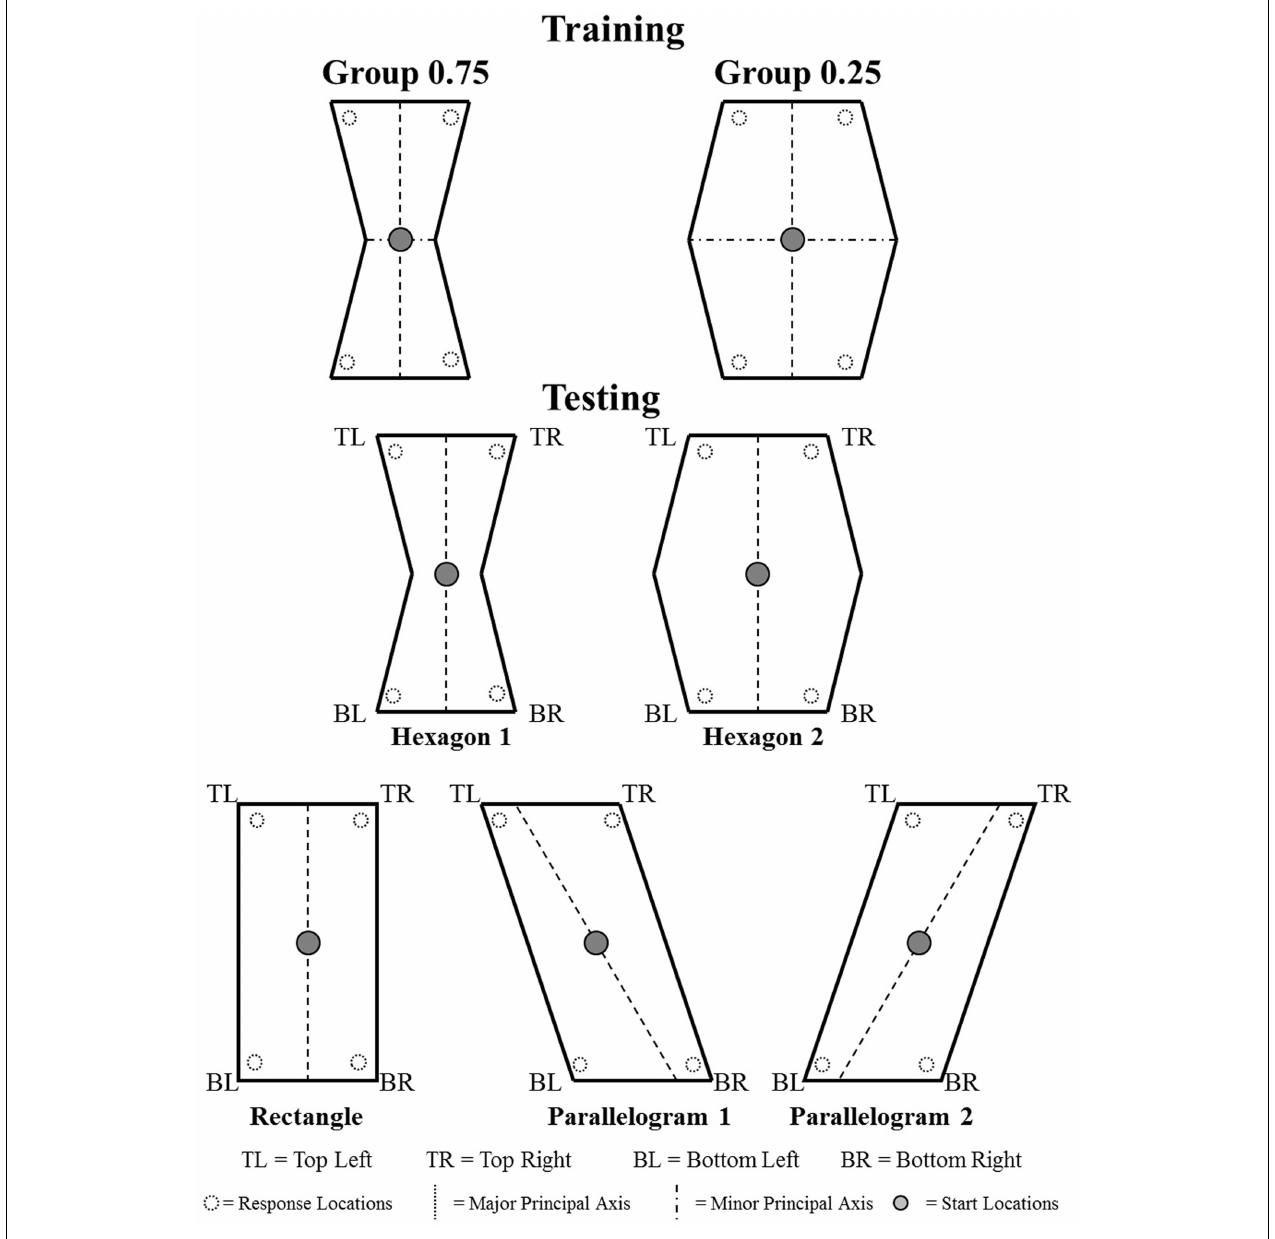
FIGURE 2 | Schematics of training and testing enclosures of Sturz and Bodily (2011a). Unfilled circles represent invisible response locations, and filled circles represent start